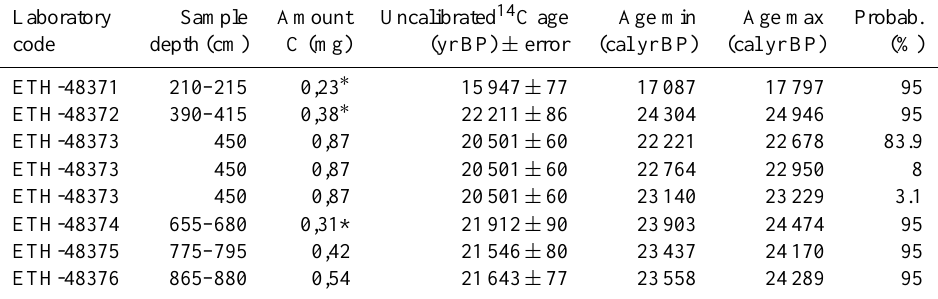
Table 1. Accelerator mass spectrometry (AMS) 14 C ages and uncertainties of sediment core PS1795, measured on planktonic foraminifera Neogloboquadrina pachyderma shells at the ETH laboratory of Ion Beam Physics in Zurich. Clam 2.1 (Blaauw, 2010) and the Marine09 calibration curve (Reimer et al., 2009) were used to calculate calendar years before present (cal yr